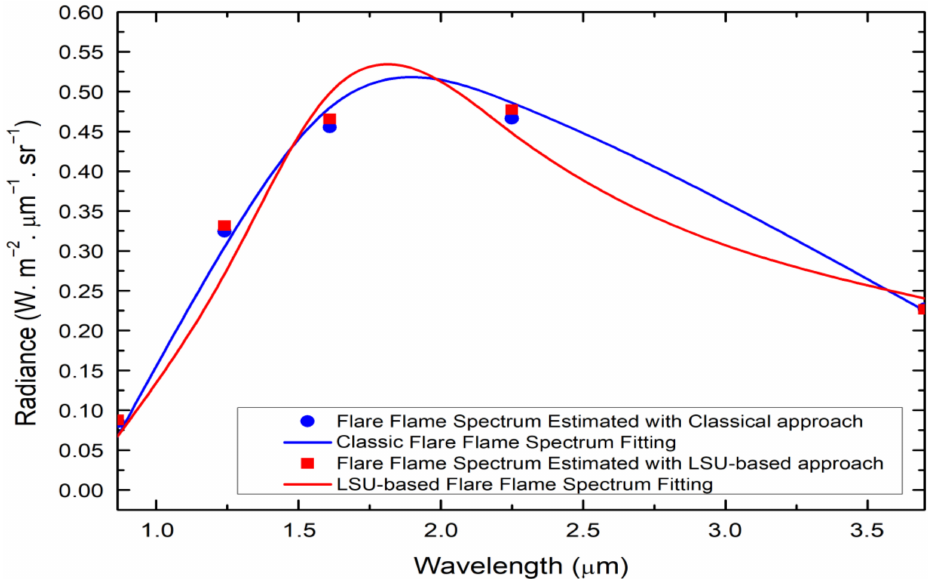
Figure 7. Planck curve fits for a flare flame pixel and a flare flame pure spectra, estimated from synthetic data (with 1550 Kelvin for the temperature and 1.55 × 10 − 5 for the